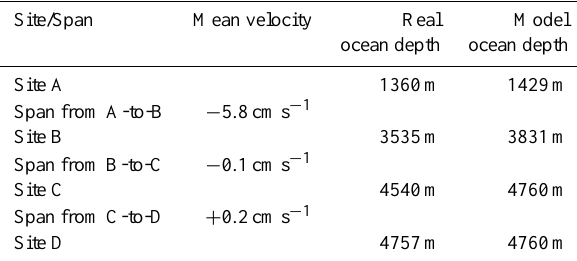
Table 1. Time-mean near-bottom meridional velocity from the OFES model averaged over the horizontal span between the indi- cated pairs of PIES/CPIES and over the deepest three layers (com- mon to both sites) above the model ocean bottom. Negative velocity indicates southward flow. Also shown are the real ocean depths at each of the actual PIES/CPIES sites and the model ocean depths at the nearest model grid